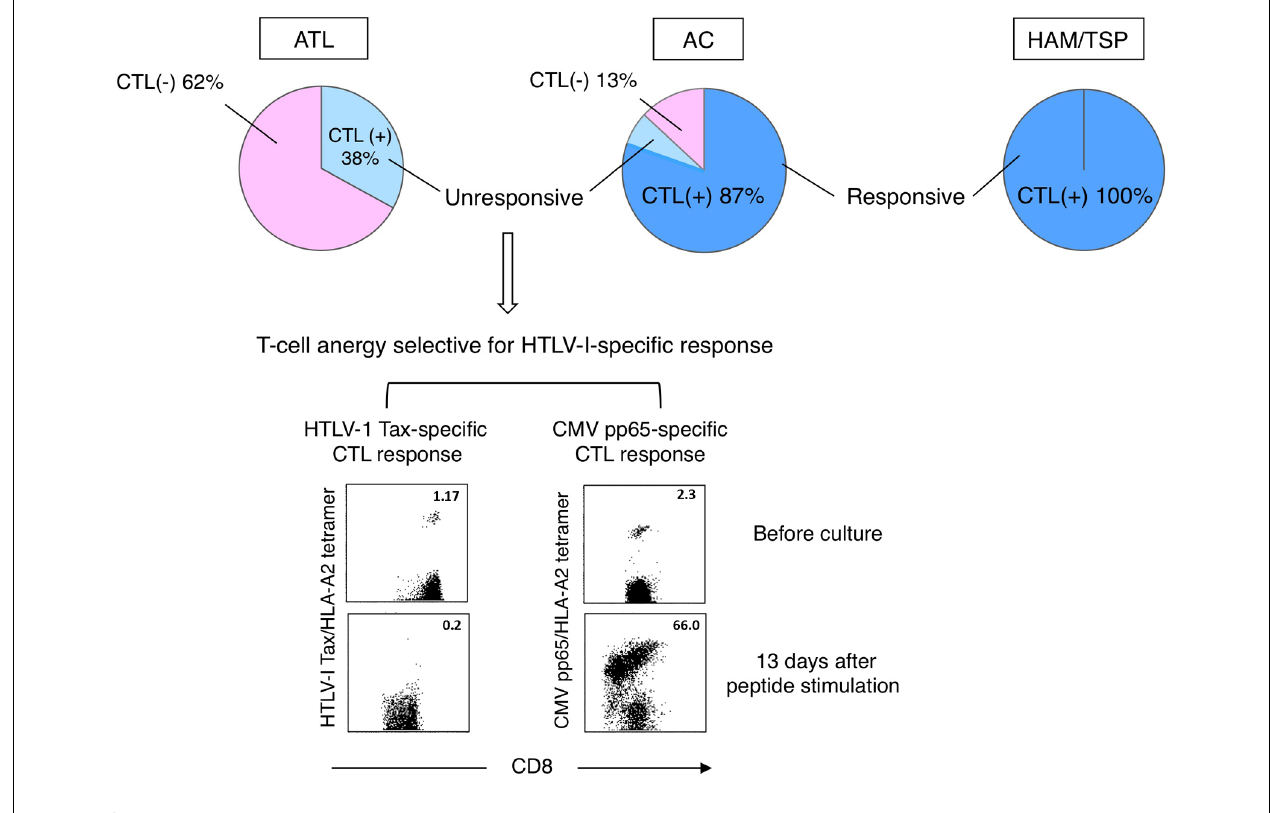
FIGURE 2 | Selective loss or anergy ofTax-specific CTLs in a subset of ACs. Incidences ofTax-specific CTL detection in CD8 + PBMC vary among diseases (top).Tax-specific CTLs detected in HAM/TSP patients and most of